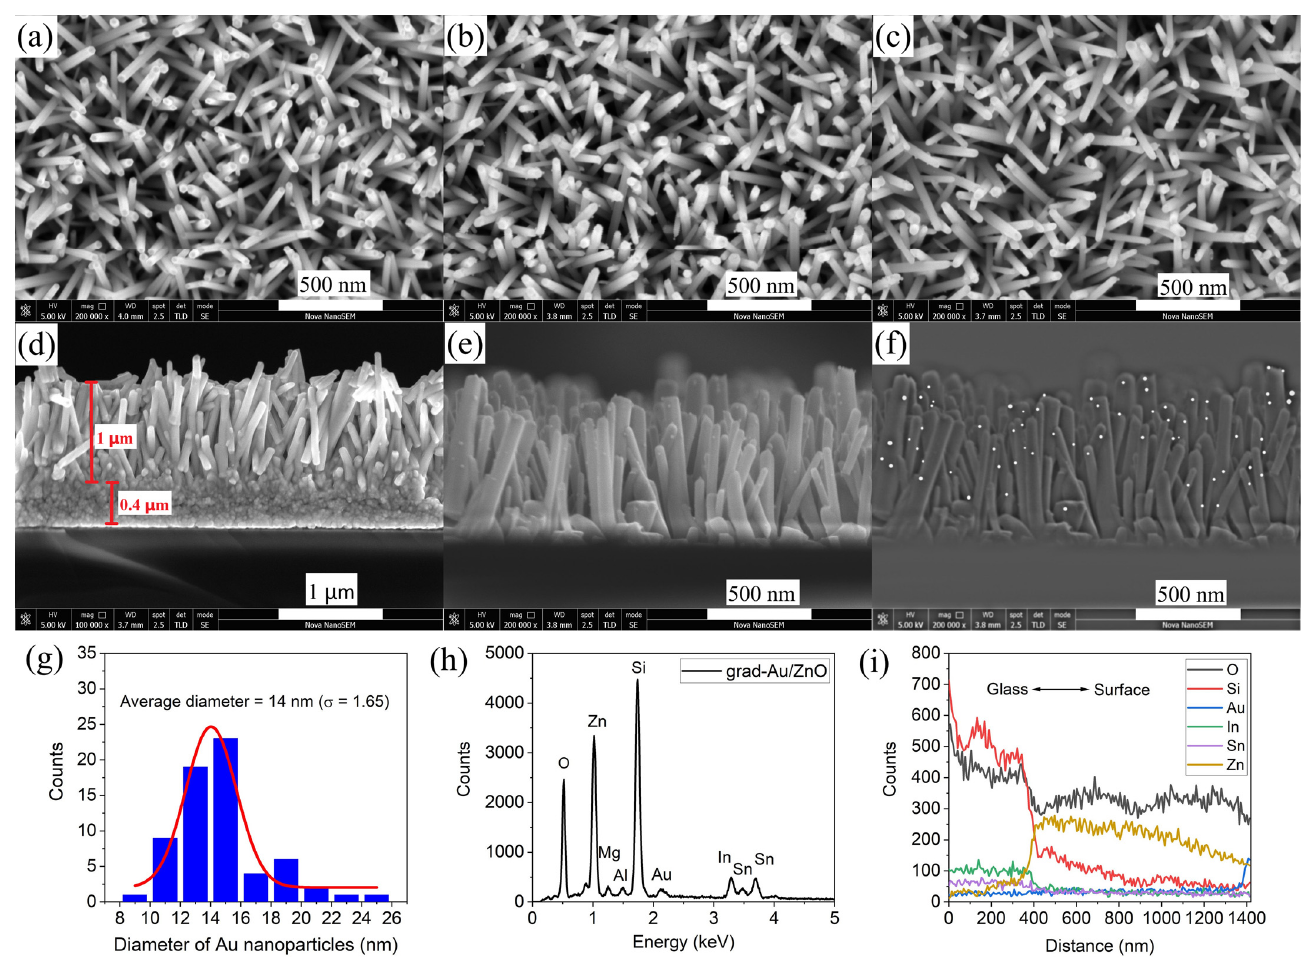
Figure 2. SEM micrographs of NRs ( a ) ZnO, ( b ) Au/ZnO, ( c ) grad-Au/ZnO, cross-sectional views of NRs ( d ) ZnO with the seed layer and ( e ) grad-Au/ZnO, ( f ) corresponding processed image for ( g ) Au NPs size distribution, and ( h , i ) EDX spectrum and line profile across grad-Au/ZnO.